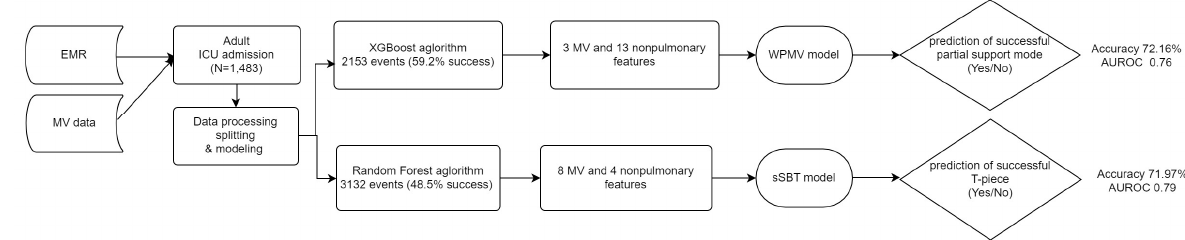
Figure 5. The illustration of our tangible results.